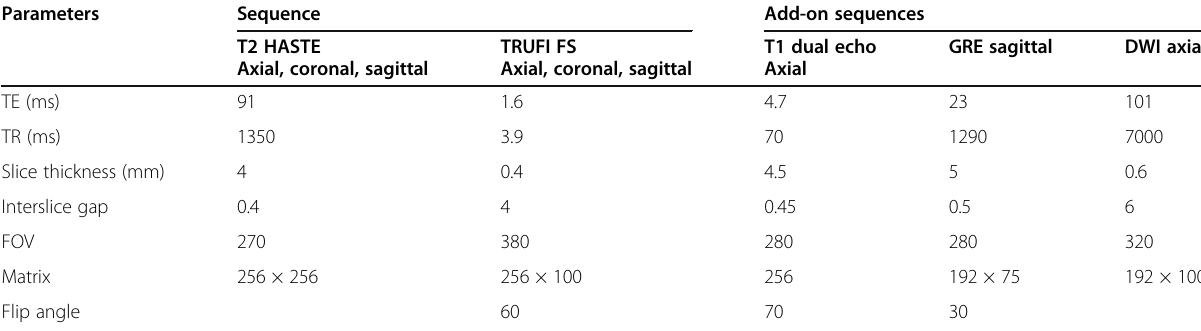
Table 1 MRI protocol for assessment of patient with suspected placenta accreta spectrum disease Parameters